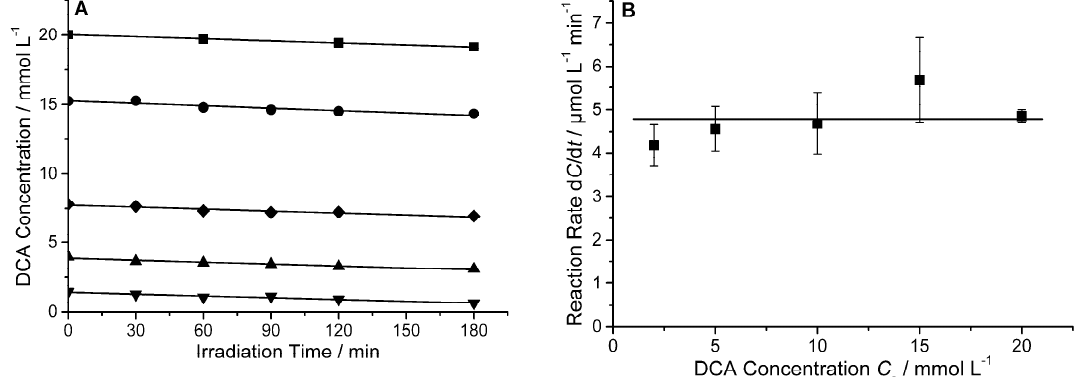
Figure 1. Photocatalytic degradation of dichloroacetic acid (DCA) varying the initial concentration: ( A ) Concentration vs. time profiles of suspensions with DCA concentrations of 20 ( ■ ), 15 ( ● ), 10 ( ♦ ), 5 ( ▲ ), and 2 mmol L − 1 ( ▼ ); ( B ) Reaction rates d C /d t (calculated from the slopes of the plots in ( A )) vs. the concentration of the stock solution C s . The line in (B) represents the average of the five data points. Experimental conditions: Hombikat UV 100, γ = 5 g L − 1 , V = 400 mL, photon flux = 10.7 µ mol min − 1 , pH 3, 10 mmol L − 1 KNO 3 , air saturated, ambient temperature.